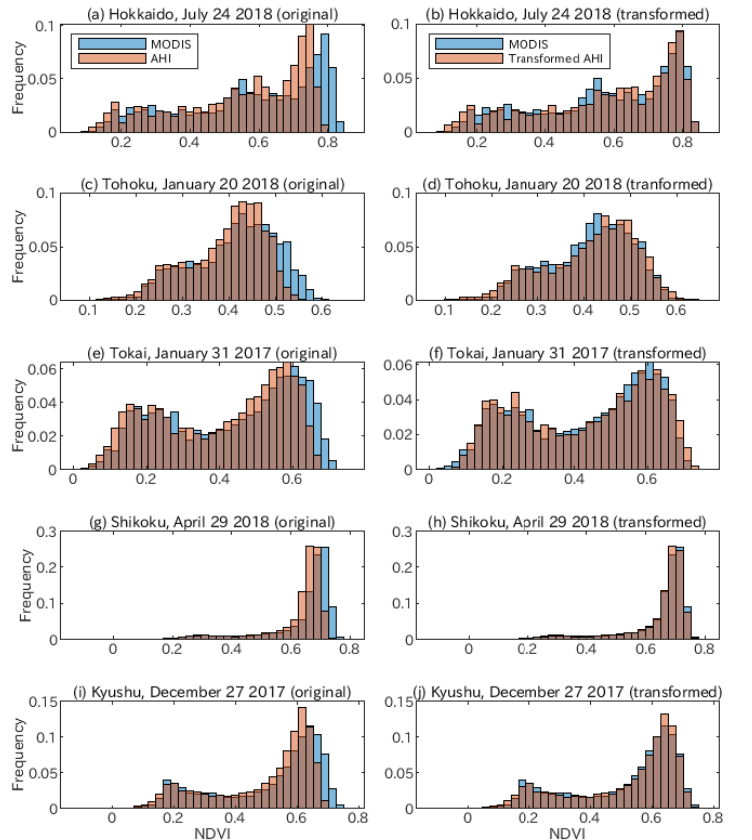
Figure 5. Relative frequency distributions of the NDVI for the AHI and MODIS ( left column ) and the transformed AHI and MODIS ( right column ) for best date. Each row of figures corresponds to a